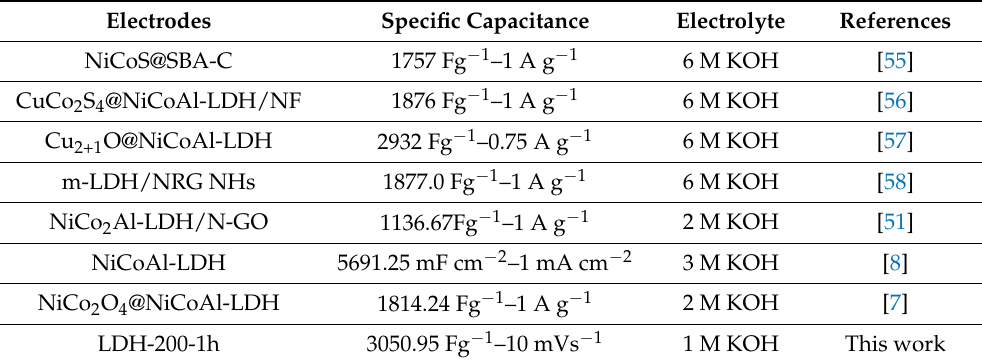
Table 3. Capacitance performance of various NiCoAL-LDH-based